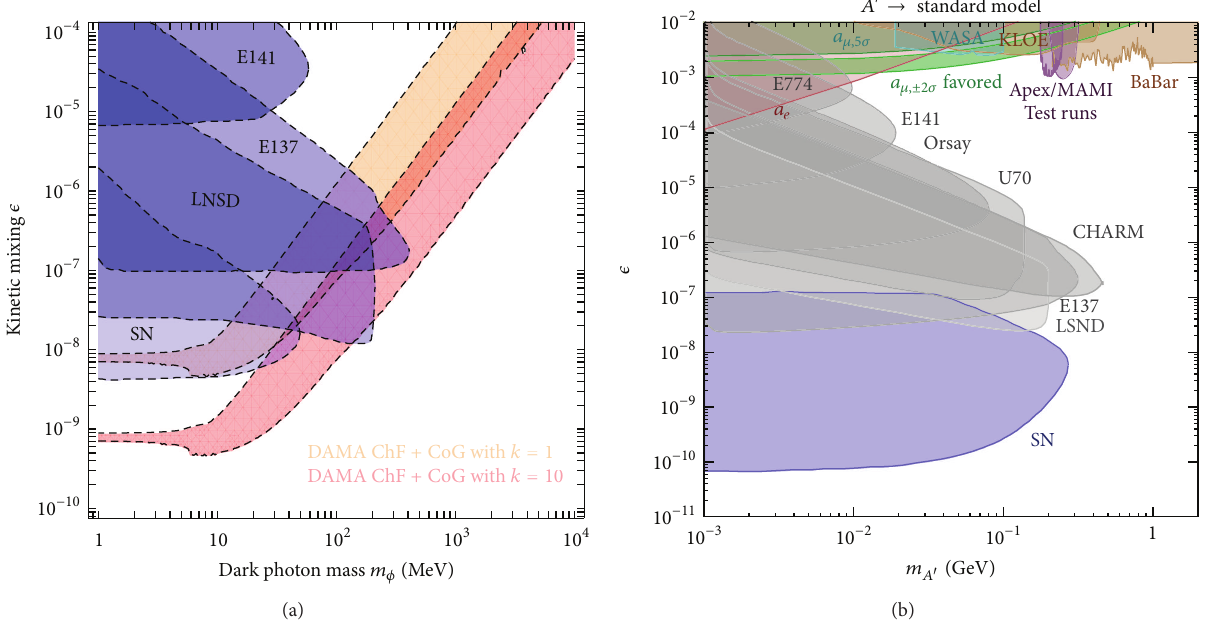
Figure 5: Allowed regions and a compilation of constraints in the (𝑚 𝜙 ,𝜖 𝜙 ) plane. (a) The upper (orange) and the lower (red) allowed regions are derived by combining the DAMA and CoGeNT annual modulation dataset. Specifically, the absence of modulation is here rejected at 8 𝜎 CL. The two regions differ in the choice of parameter 𝑘 𝜒 ; namely 𝑘 𝜒 = 1 (upper) and 𝑘 𝜒 = 10 (lower). In blue are instead represented the constraints coming from beam dumped neutrino experiments and supernovæ observations taken from [95, 96]. (b) A compilation of the latest constraints in the (𝑚 𝜙 , 𝜖 𝜙 ) plane. This plot has been taken from the following review [97]. It is worth pointing out that for 𝑚 𝜙 ≲ 10 −6 eV the parameter space of the positive results experiments in direct DM searches is basically unbounded (see, e.g., [97, Figure